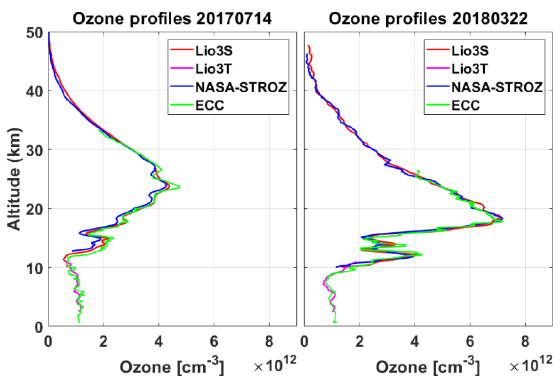
Figure 2. Ozone profiles measured by the different instruments at Observatoire de Haute-Provence on the nights of 14–15 July 2017 and 22–23 March 2018. Note the seasonal differences in the char- acter of the ozone profiles in spring and summer.